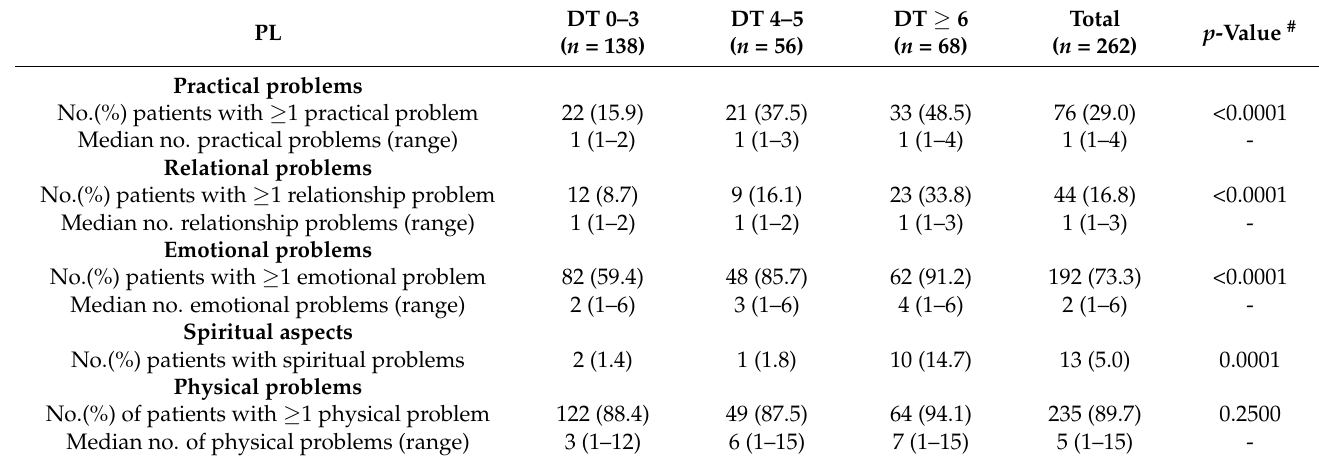
Table 2. Analysis of the PL of single subgroups for DT